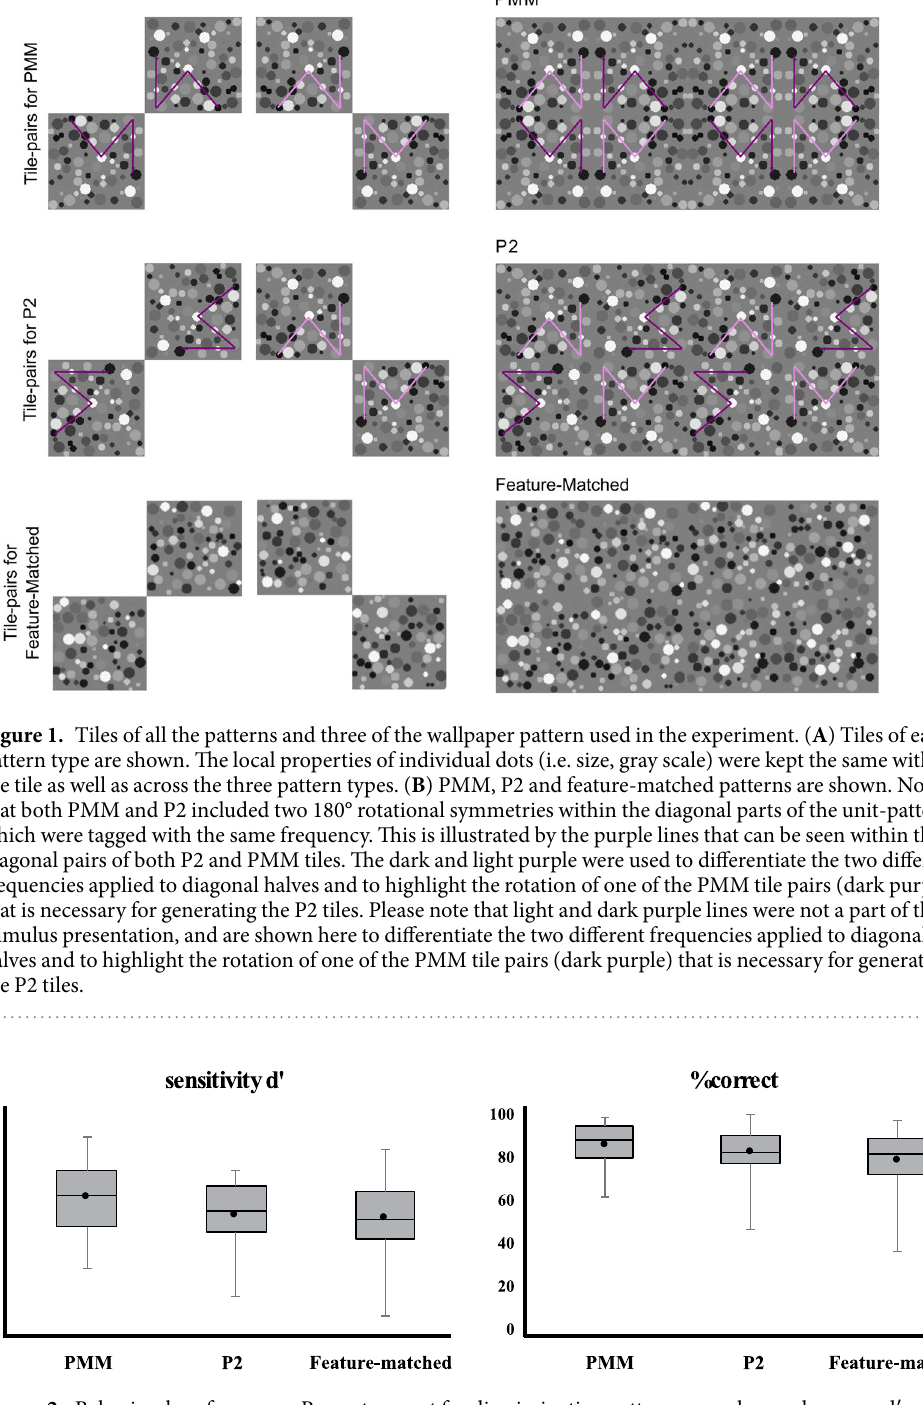
eigenvalue problem into a small number of physiologically reliable components (RCs). Both for time and fre- quency domain, the RCA was computed separately for each frequency pair, and for the self and mutual terms, using data from all conditions (3 conditions per frequency pair). We will first consider the results in the frequency domain. For the self-terms, the first two components explained a substantial amount of the trial-to-trial reliability for both frequency pairs (53% and 50%), and